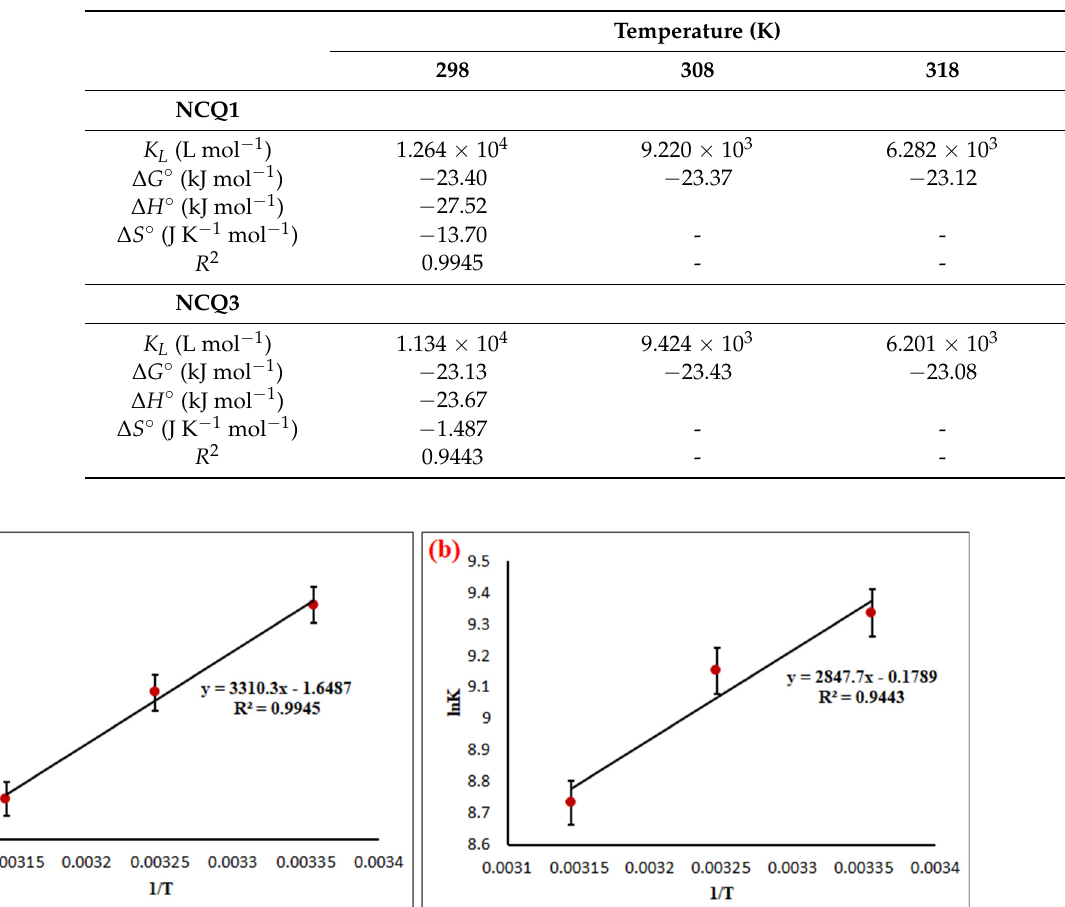
Table 6. Thermodynamics factors for CV dye adsorption on both NCQ1 and NCQ3 adsorbents.